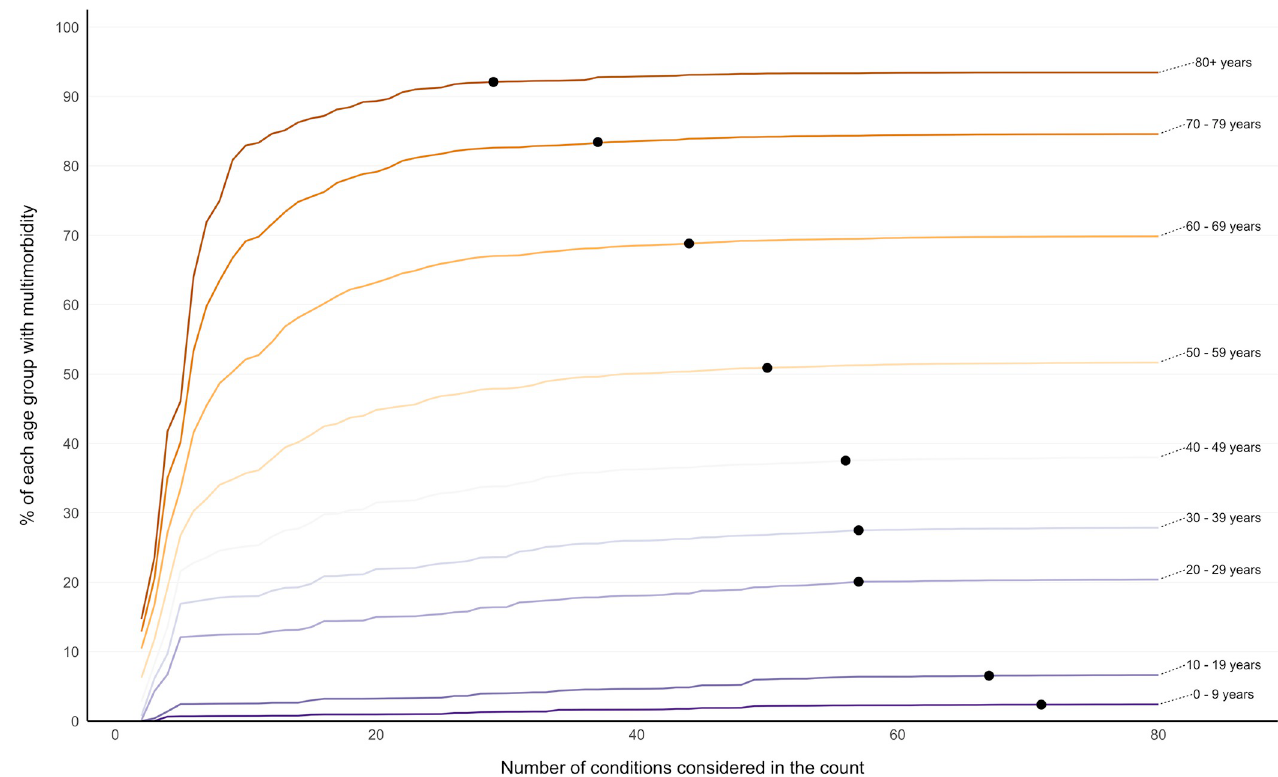
Fig 2. Age-stratified multimorbidity prevalence according to number of conditions considered, reporting the ceiling effect where adding additional conditions had little impact on prevalence. Labelled coloured lines represent multimorbidity prevalence calculated when considering different numbers of conditions in the count ranging from 2 to all 80 conditions stratified into age groups. Black dots represent the number of conditions at which RR > 0.99 of multimorbidity prevalence of having the same multimorbidity prevalence when all 80 conditions were considered (ceiling effect): 0–9 years at 71 conditions, 10–19 years at 67 conditions, 20–29 conditions at 57 conditions, 30–39 years at 57 conditions, 40–49 years at 56 conditions, 50–59 years at 50 conditions, 60–69 years at 44 conditions, 70–79 years at 37 conditions, 80+ years at 29 conditions. RR, relative risk.